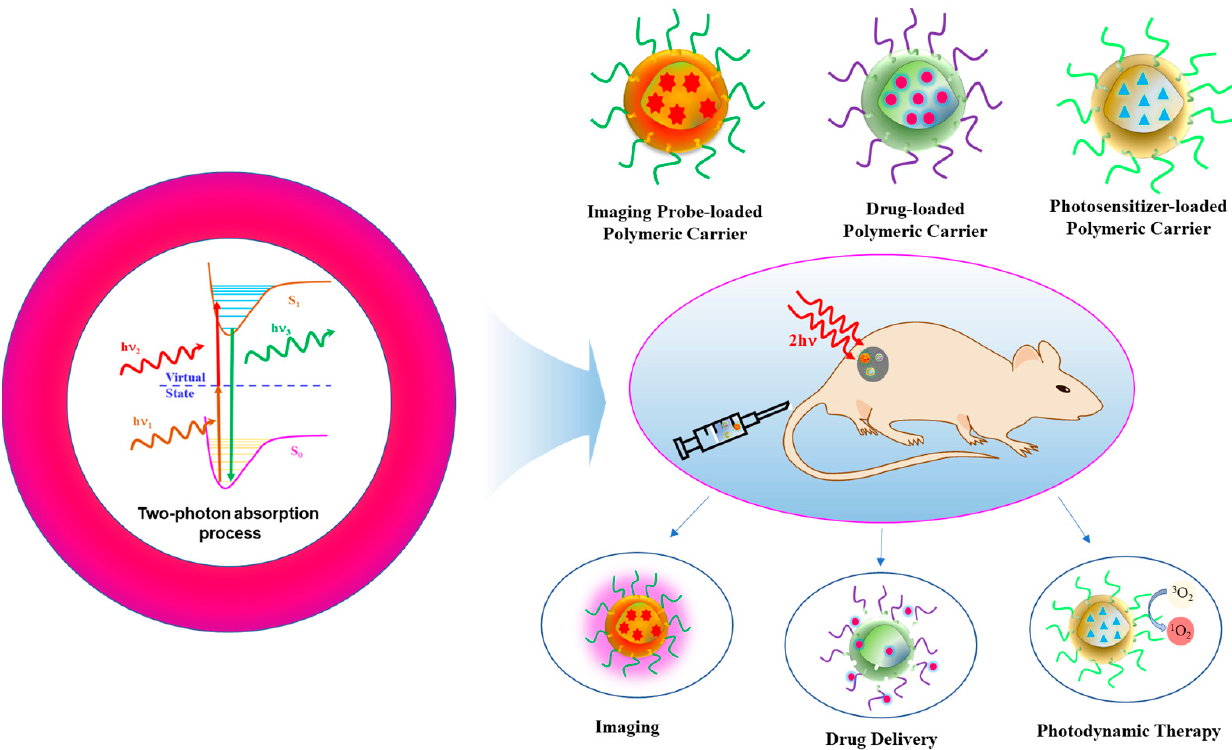
Figure 1. Basic principle of two-photon absorption process. Schematic representations of polymeric carriers loaded with imaging probe or therapeutic agents (drugs or photosensitizer) for two-photon- assisted imaging, drug delivery and photodynamic therapy.